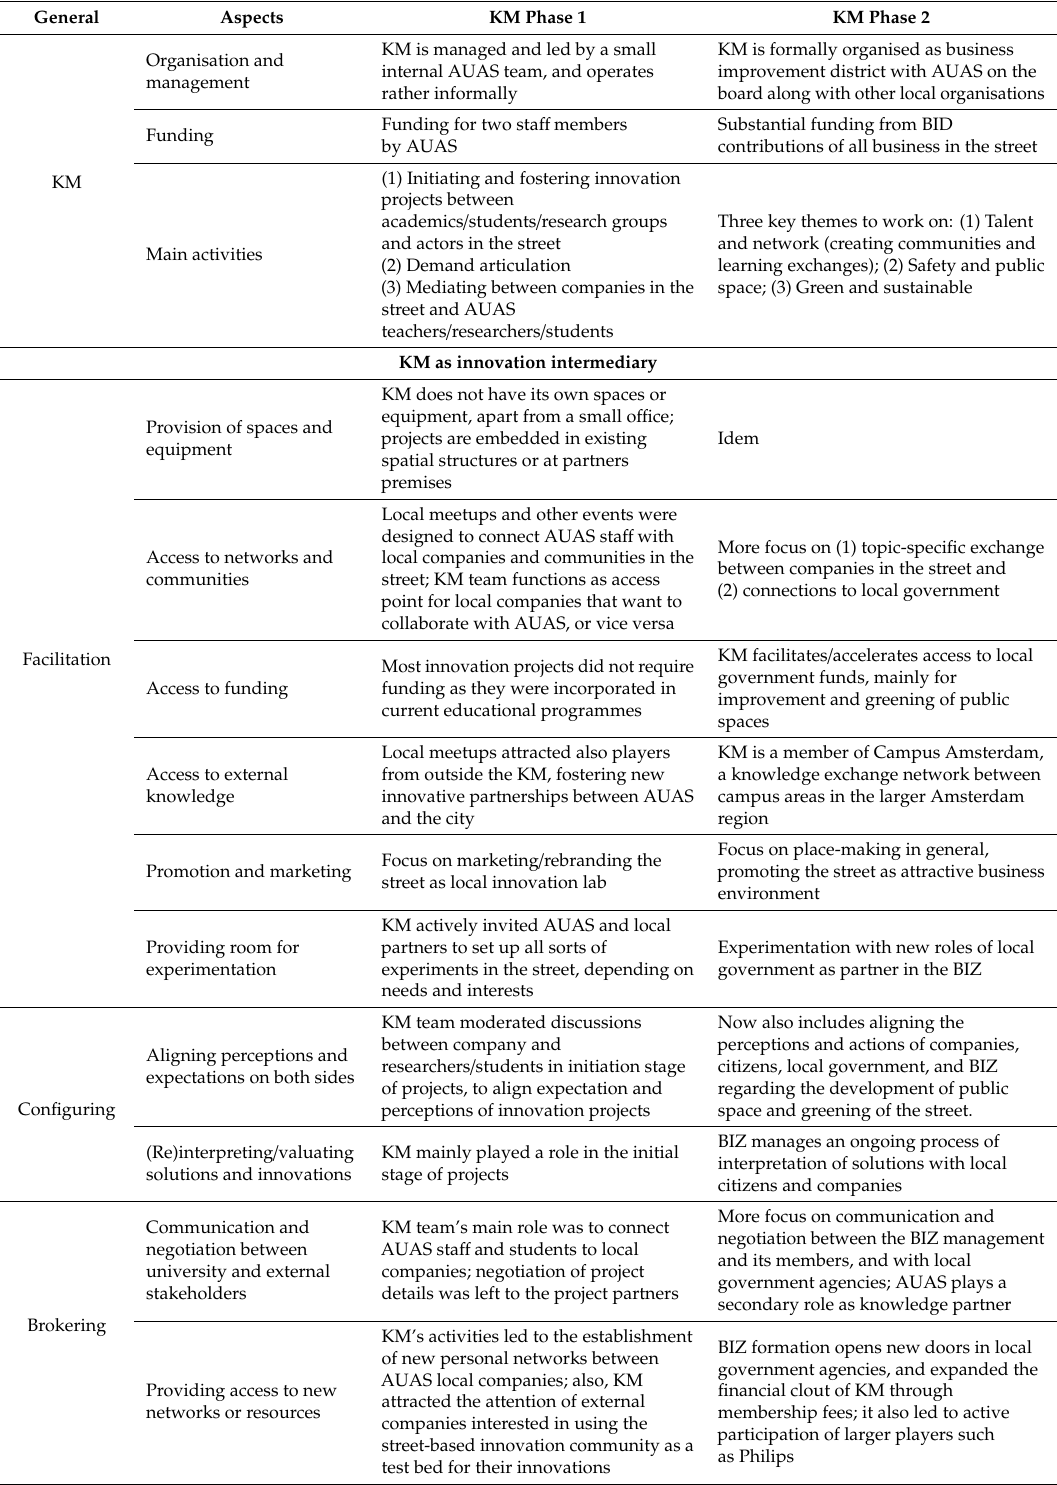
Table 4. Summary of results. BIZ, business investment